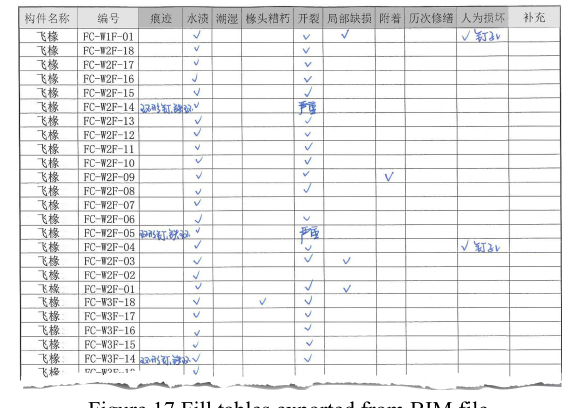
Figure 17 Fill tables exported from BIM file